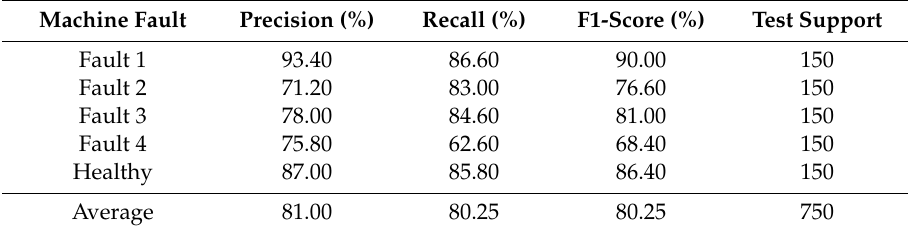
Table 4. Classification report when loading conditions are not used.